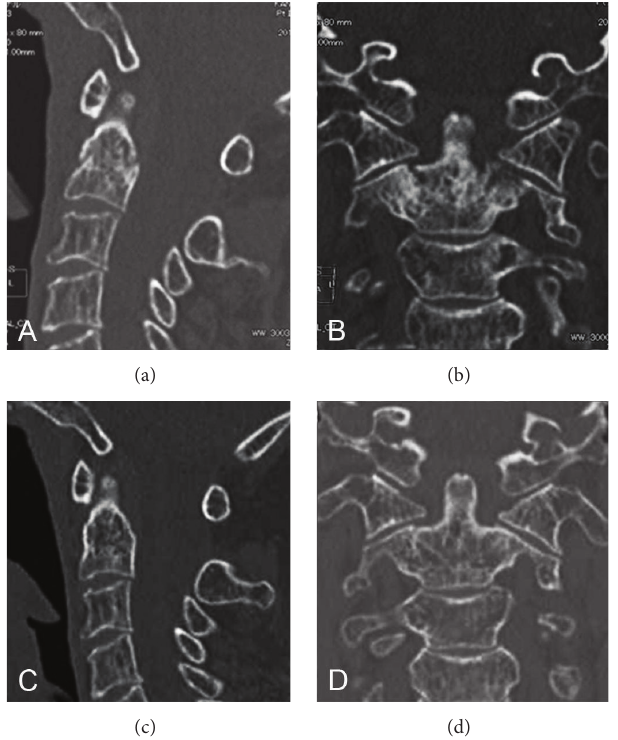
Figure 3: Sagittal (a, c) and coronal (b, d) reconstruction images of computed tomography (CT). (a, b) Anderson type III odontoid fracture was confirmed at the time of initial diagnosis. (c, d) Follow-up CT obtained after 6-month conservative treatment clearly revealed complete bone